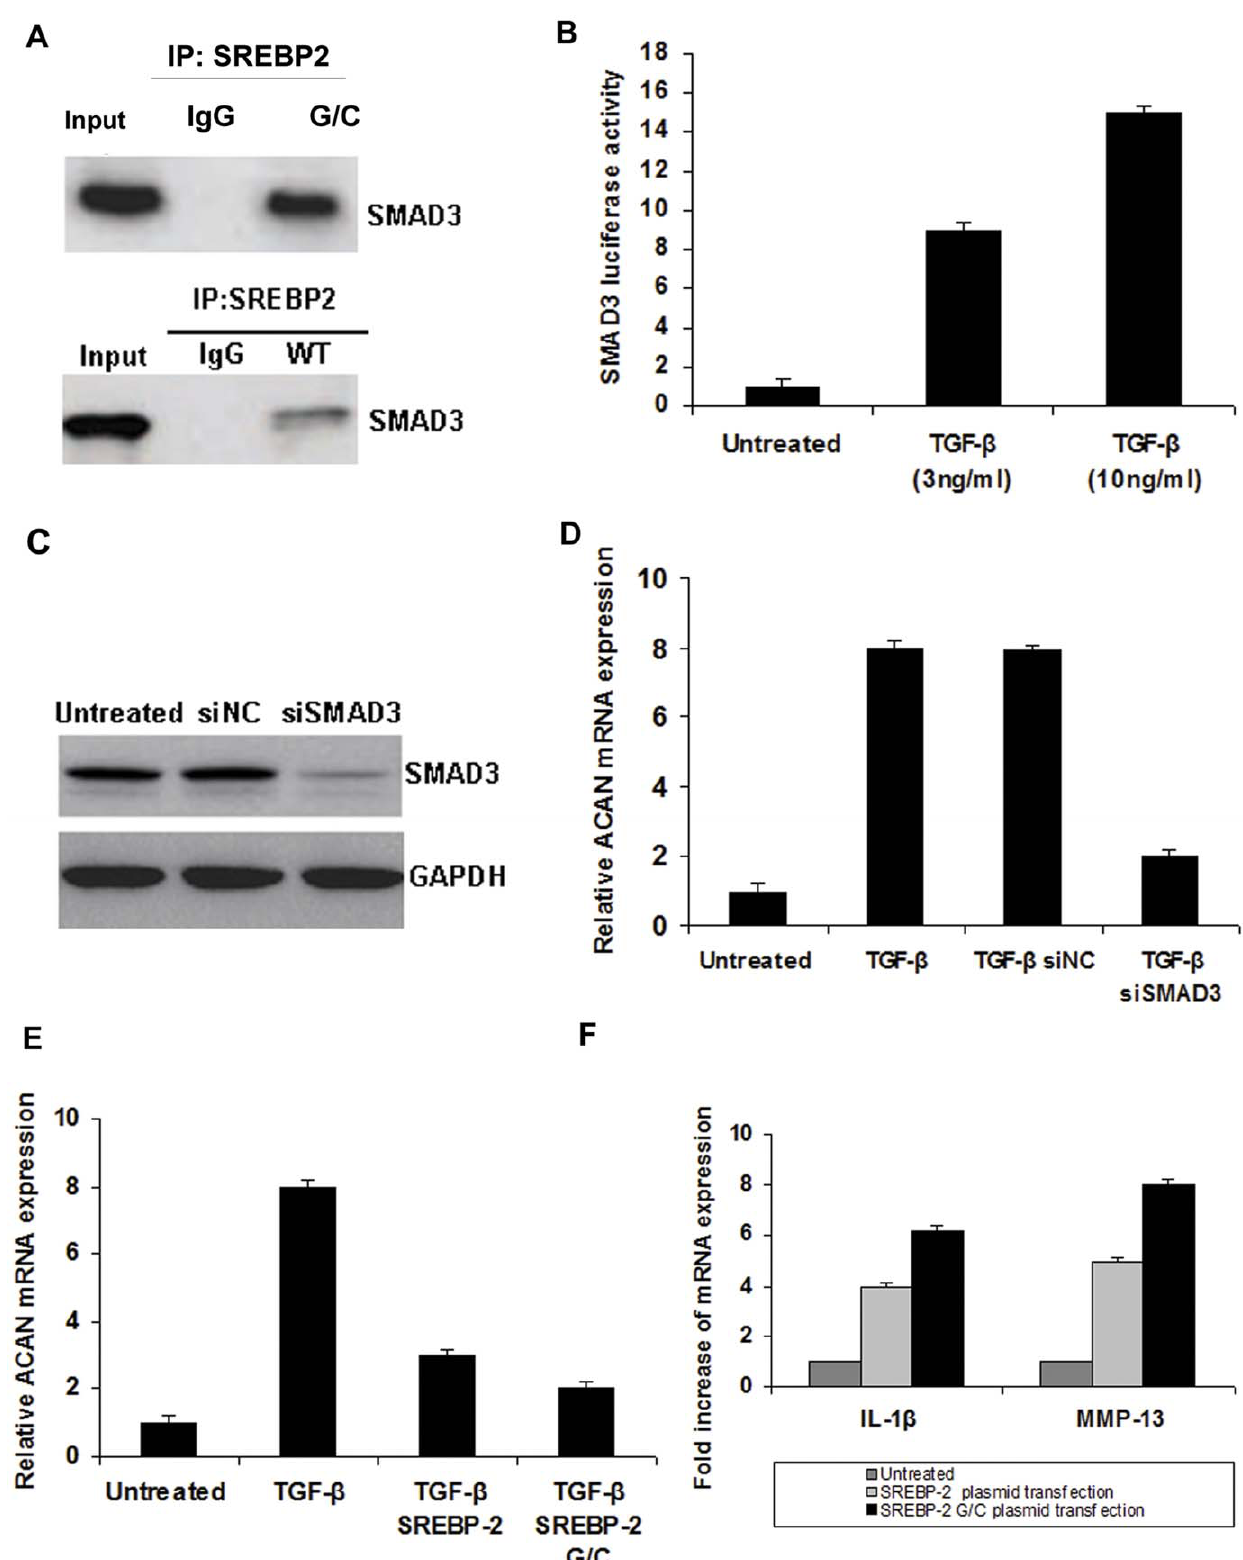
Figure 6. Transfection of chondrocytes with plasmids and interactions between SREBP-2 and Smad3. ( A ) Primary osteoarthritic chondrocytes were transfected by electroporation with SREBP-2 WT and SREBP-2 G/C plasmids. 24 h post transfection we performed immunoprecipitation for SREBP-2 and tested the interaction with Smad3. ( B ) Normal chondrocytes were treated with TGF- b (3, 10 ng/ml) and Smad3 activity was assessed by luciferase activity (GACA) 12-luc plasmid, 12 h post transfection. ( C ) Western blot analysis showing Smad3 protein